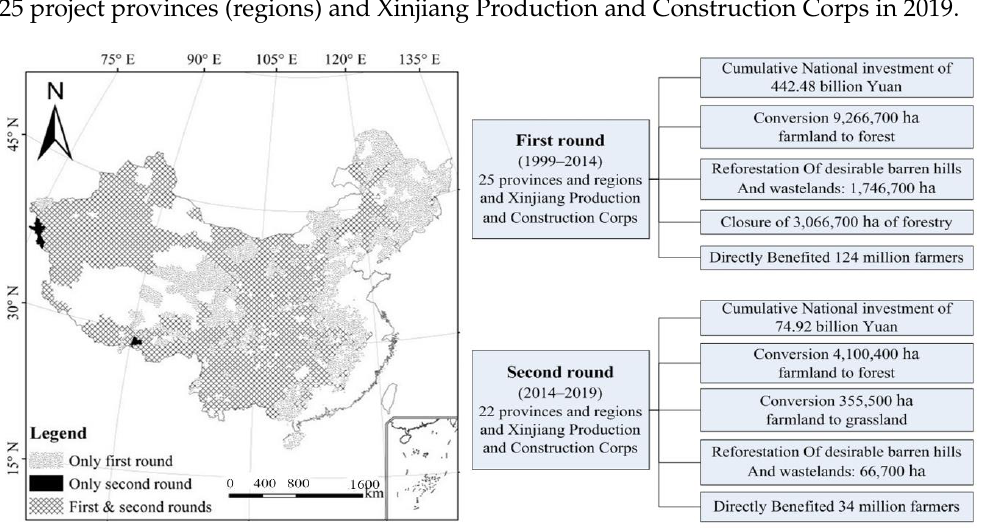
Figure 4. Spatial patterns and achievements in two phases of the CFFG project.